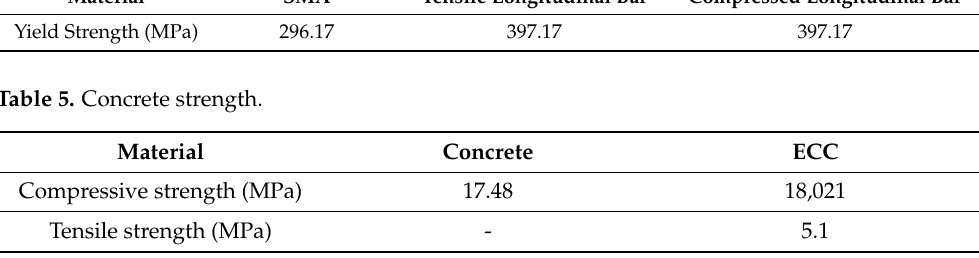
Table 4. Yield strength of longitudinal reinforcement.